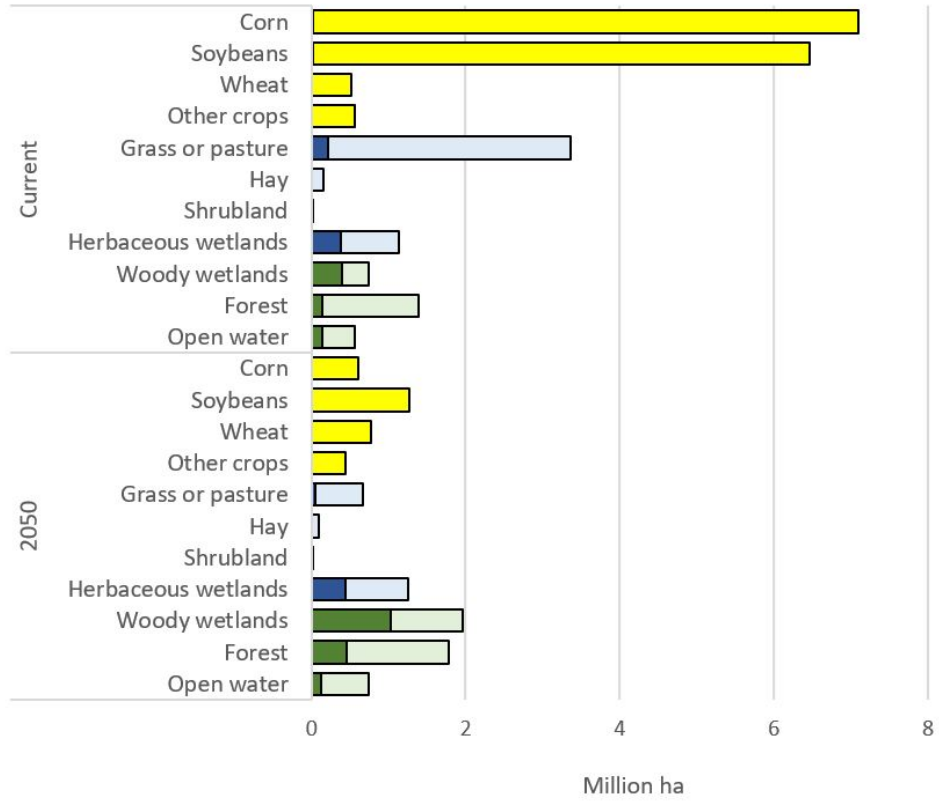
Figure 3. Total amount of land cover classes in recent and future areas with suitability > 0.5. Areas with conservation protection status are shown in dark blue (grassland-type land cover) or dark green (forest and water land